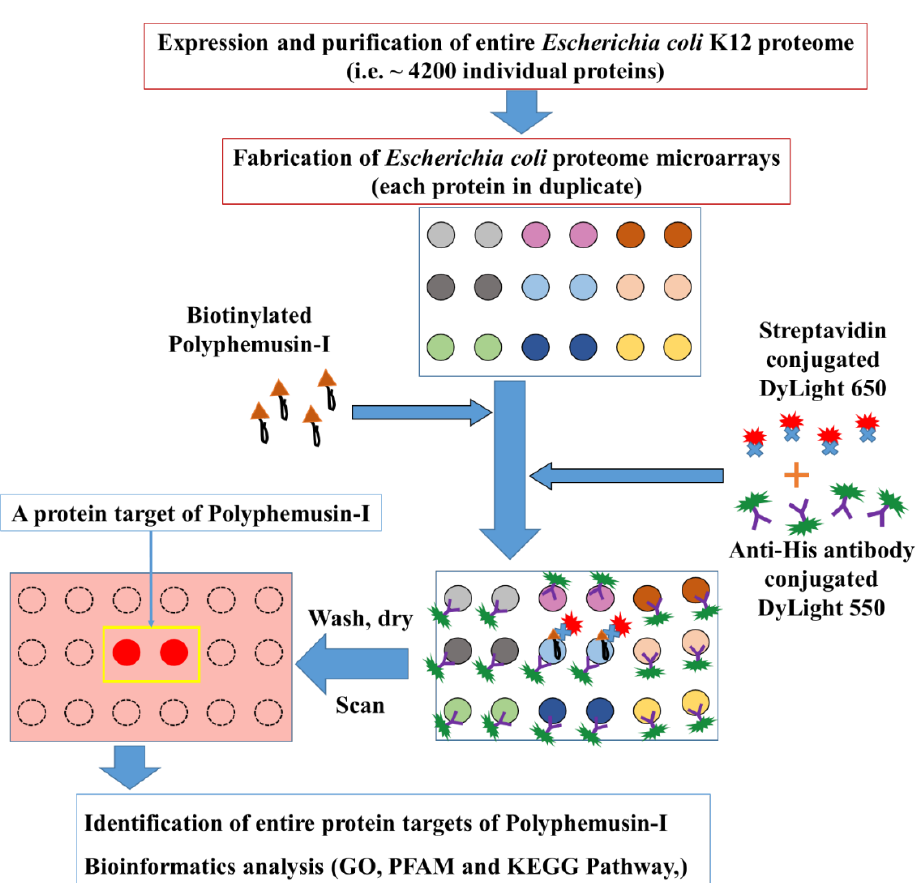
Figure 1. Schematic diagram for the identification of the protein targets of polyphemusin-I using Escherichia coli proteome microarrays. The entire proteome of Escherichia coli K12 was individually purified and spotted in duplicate on aldehyde coated glass slides (different colors represent different proteins in duplicate) to fabricate Escherichia coli proteome microarrays. To screen and identify the protein targets, biotinylated Polyphemusin-I was probed on Escherichia coli proteome microarrays followed by probing with streptavidin conjugated DyLight 650 and anti-His antibody conjugated DyLight 550. Here, streptavidin conjugated DyLight 650 and anti-His antibody conjugated DyLight 550 facilitated the detection of biotinylated polyphemusin-I and 6×His tag Escherichia coli proteins on Escherichia coli proteome microarrays, respectively. Statistical cutoff parameters were used to identify the potential protein targets of polyphemusin-I and these identified protein targets were analyzed with bioinformatics tools, like gene ontology (GO), protein family (PFAM), and Kyoto Encyclopedia of Genes and Genomes (KEGG).